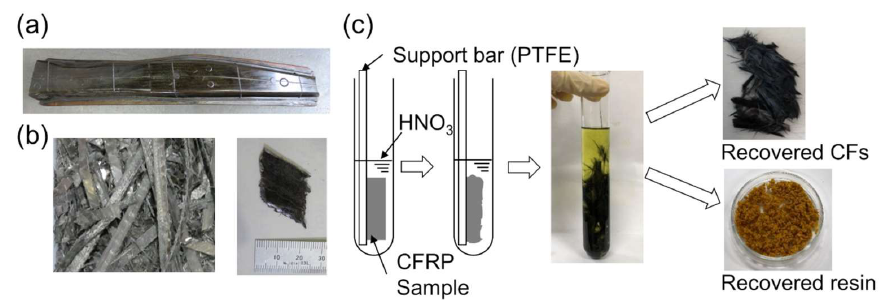
Figure 1. ( a ) CFRP automotive prototype waste manufactured from virgin carbon fibers and fully cured epoxy resin; ( b ) CFRP specimen used in this research, ( c ) decomposition and recovery process of carbon fiber and resin from CFRP immersed in HNO 3 .